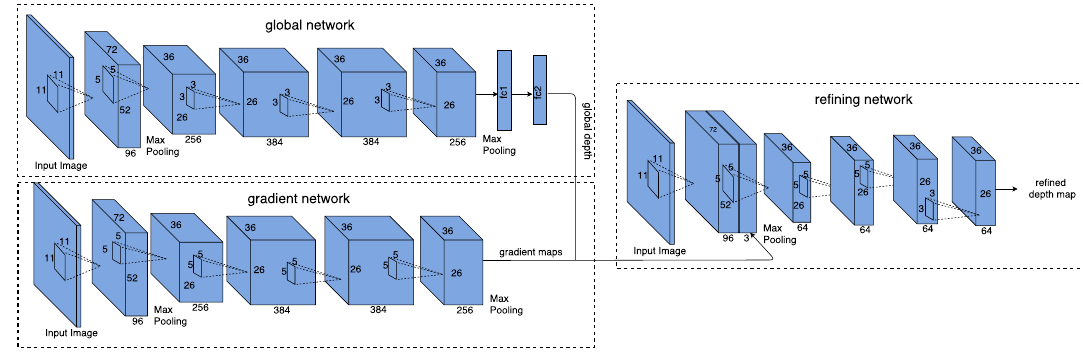
Figure 3. Depth estimation network.